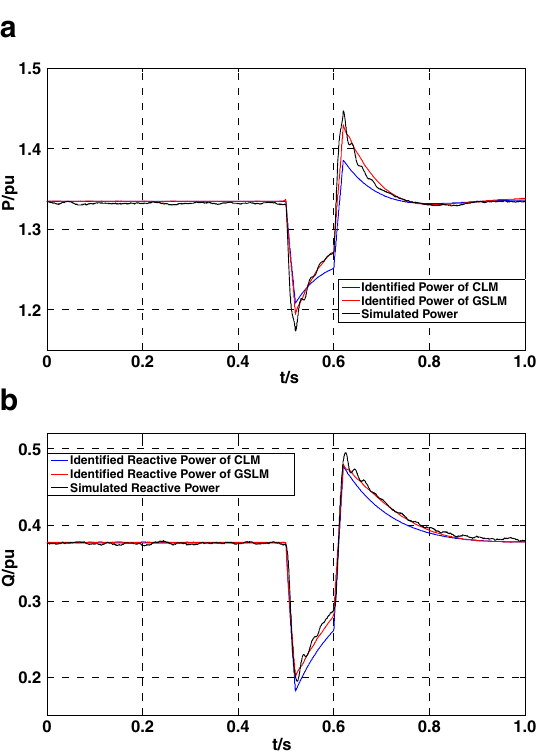
Fig. 14 Fitting curves of the first load level under charging state